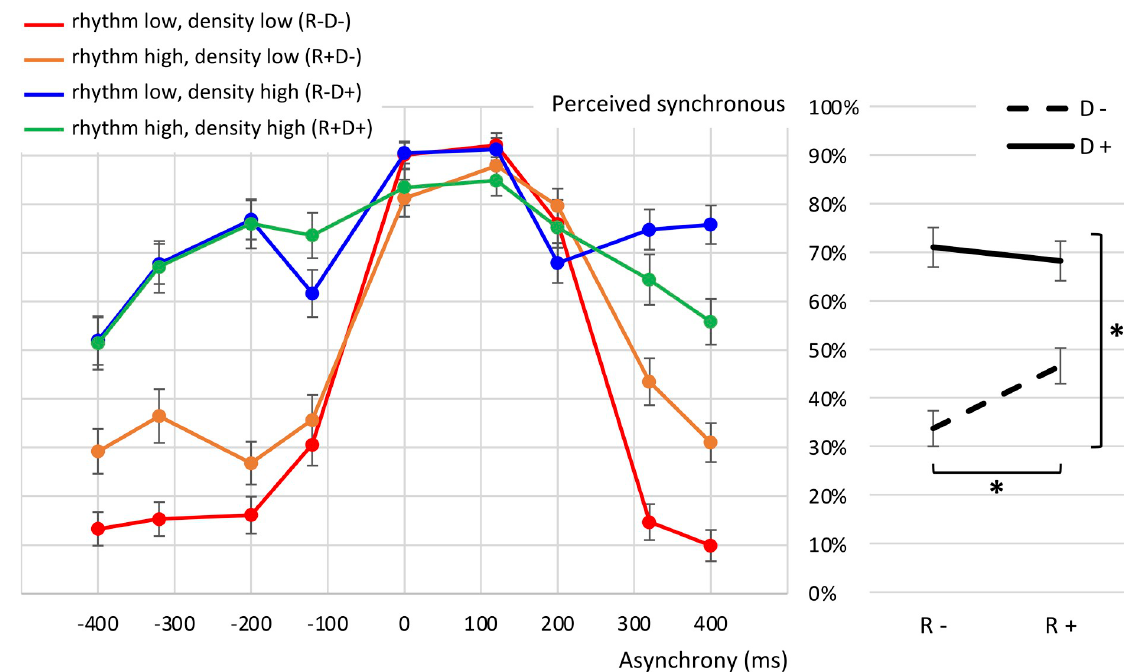
Fig 6. Mean percentages of trials perceived as synchronous, Study 2. On the left hand side, all scores are fanned out for the level combinations of the factors asynchrony size, asynchrony type, Event density and Rhythmicity. The right hand side chart illustrates the significant Event Density x Rhythmicity